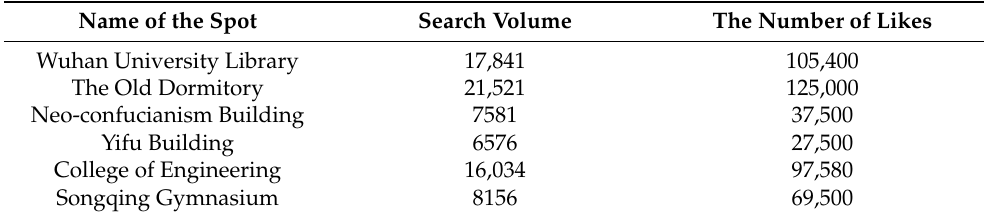
Table 1. The search volume and the number of likes of each scenic spot on Weibo within one day. Name of the Spot Search Volume The Number of